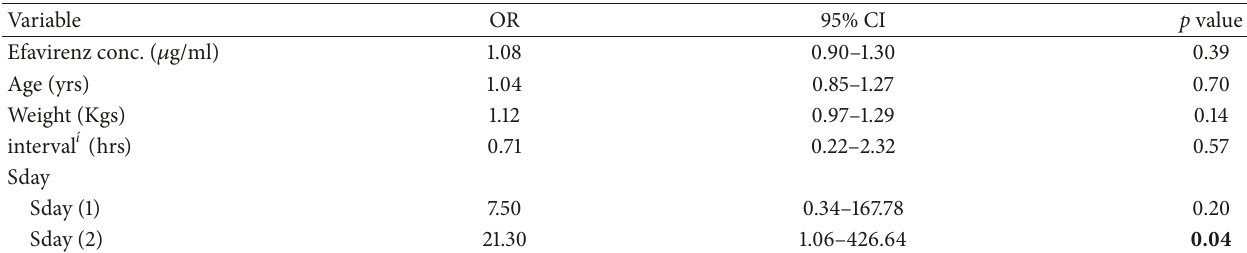
Table 3: Factors associated with progesterone levels among HIV positive women on efavirenz based HAART in binary logistic regression